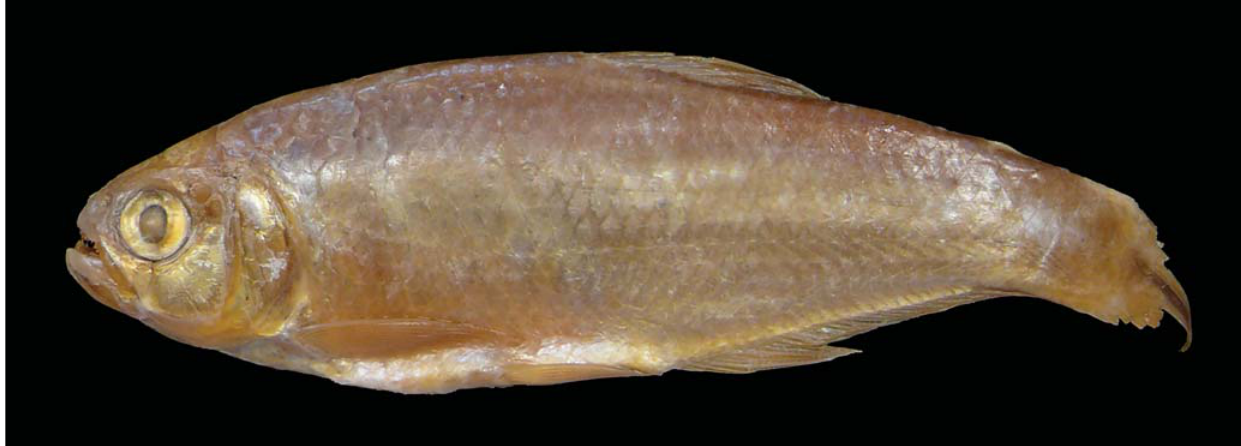
Fig. 18. Hemibrycon polyodon , BMNH 1858.7.25.41, holotype, female, 70.4 mm SL, Guayaquil, Ecuador.